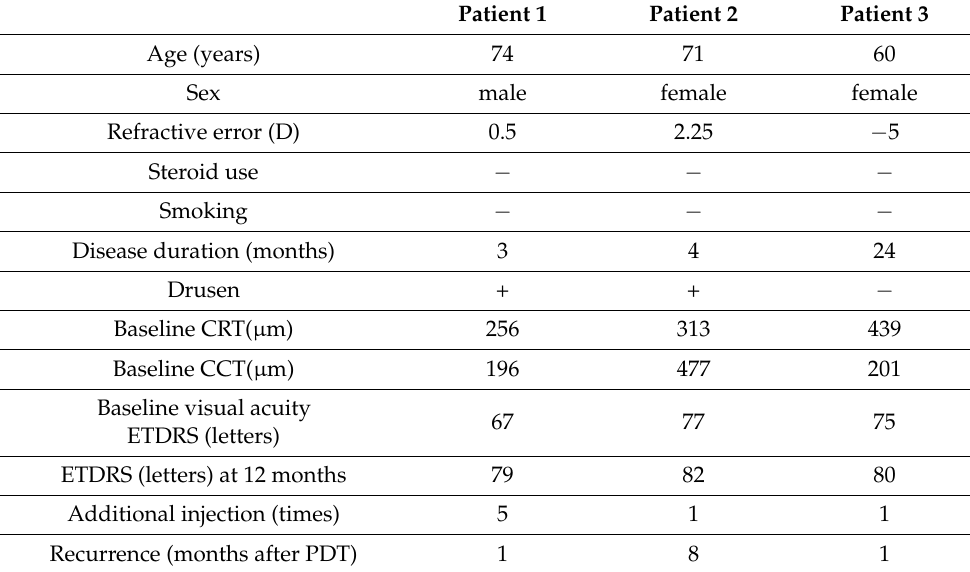
Figure 2. Central macular retinal thickness (CRT) & central macular choroidal thickness (CCT) in eyes with pachychoroid neovasculopathy treated with 2/3PDT. * p < 0.05. Table 2. Patients who needed additional treatment at